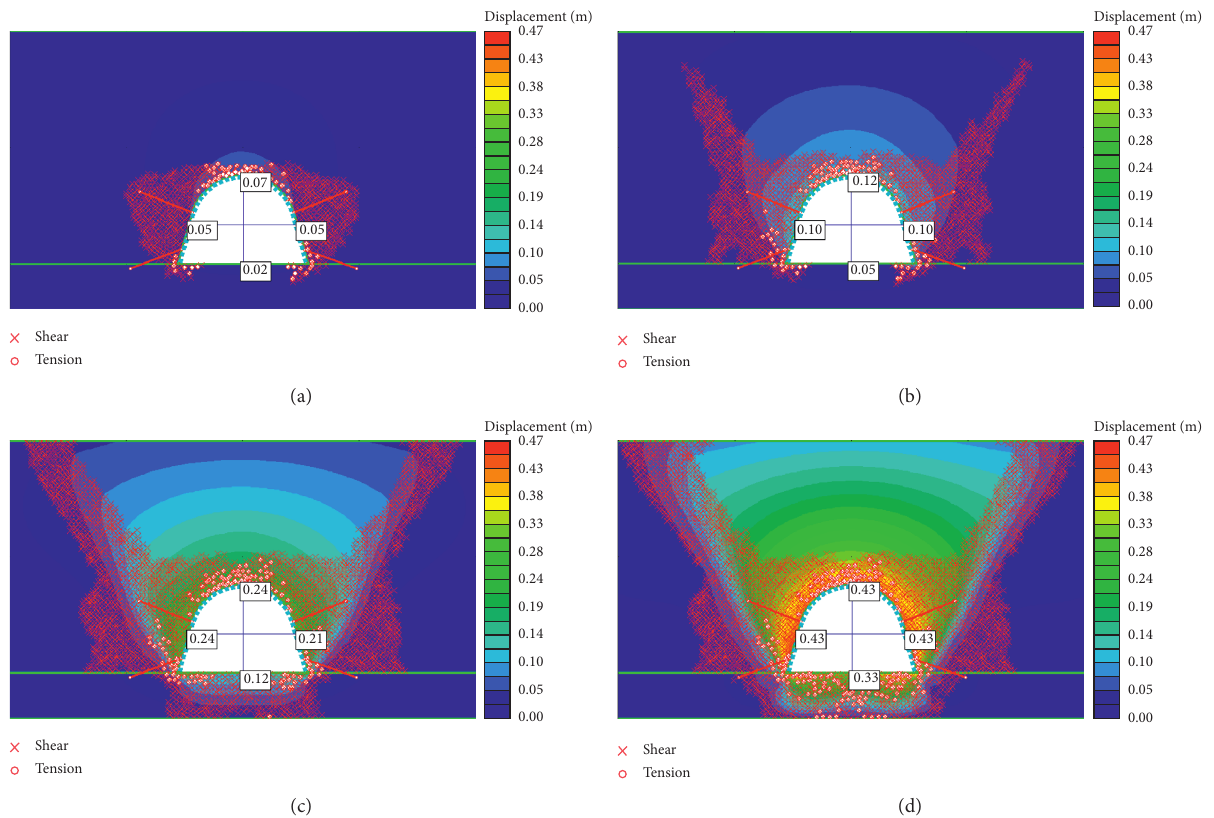
Figure 7: Evolution of roadway deformation and the extent of damage around the roadway. (a) 3 d . (b) 7 d . (c) 30 d . (d) 150 d